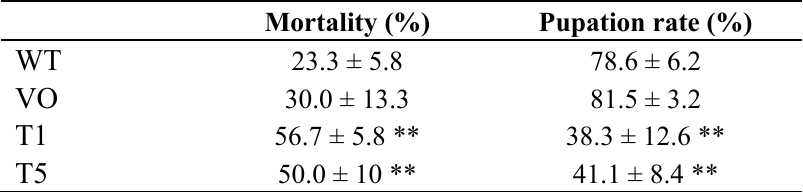
Table 2. The mortality and pupation rate of Helicoverpa armigera larvae that fed on control and SaPIN2b-overexpressing tobacco plants. Ten early second-instar H. armigera larvae were introduced to transgenic and wild type (WT) plants. VO, vector-only transgenic plants; T1 and T5, SaPIN2b-overexpressing plants. Three biological replicates were performed with three technical replicates for each treatment. The asterisks denote significant differences from the control plants ( t -test, ** indicates that p <